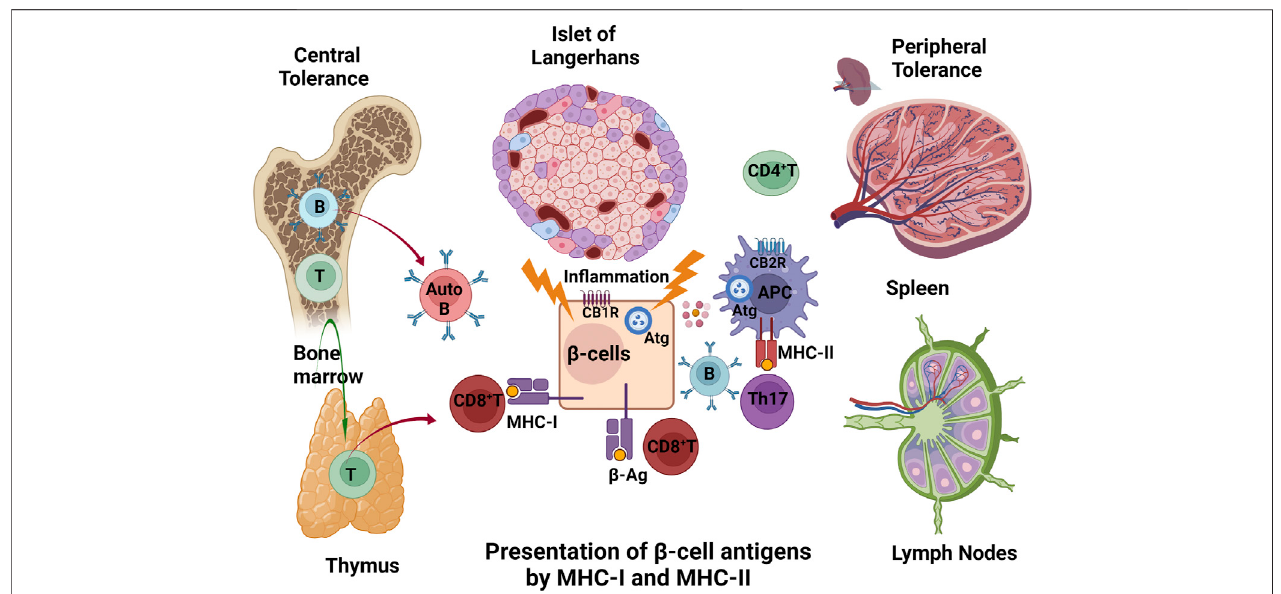
FIGURE1| CentralandperipheralbreakdownofimmunetoleranceinT1DM:Auto-reactivecytotoxicT(CD8 + T)andB(AutoB)cellsescapefromprimarylymphoid (bonemarrowandthymus)andsecondarylymphoidorgans(spleenandlymphnodes).The β -cellsexposedtoviralinfections,anarrayofcytokines(IL-1 β ,TNF- α ,IFN- γ ), injury by toxins, and stress (such as increased ROS production, ER stress, post-translational modi fi cations) conditions may present their auto/neoantigenic peptides ( β - Ag)onMHC-Icomplexestothecellsurface,therebyattractingcytotoxicCD8 + Tcells.Autoreactiveantigensthatareendocytosedbyantigenpresentingcells(APC) activate CD4 + Th17 T and B cells. CB1R in β -cells and CB2R in APC cells are players in the outcome to β -cells, possibly through actions on autophagy (Atg).